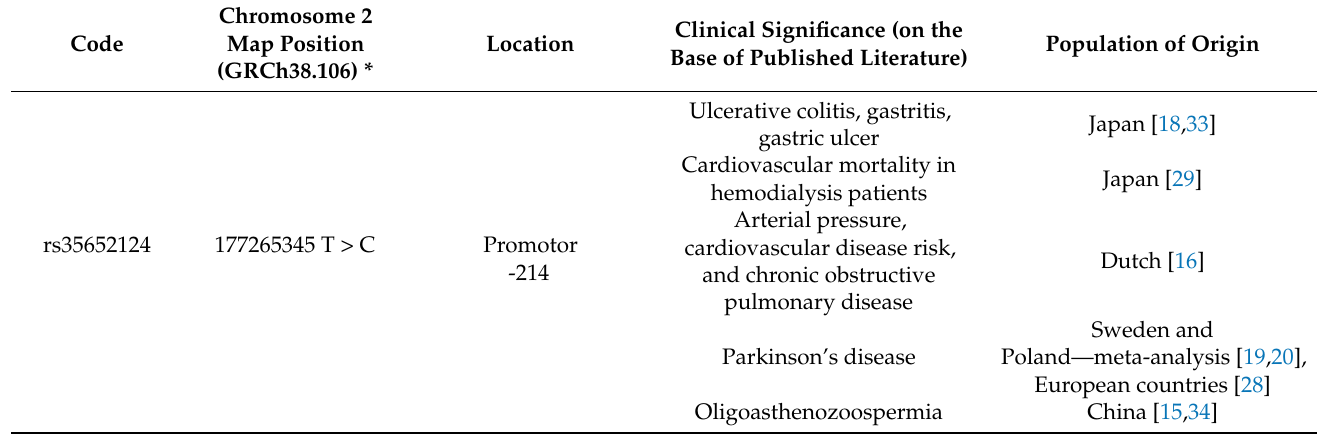
Table 1. Single nucleotide polymorphism of Nrf2 was examined in the study and literature reports of its clinical